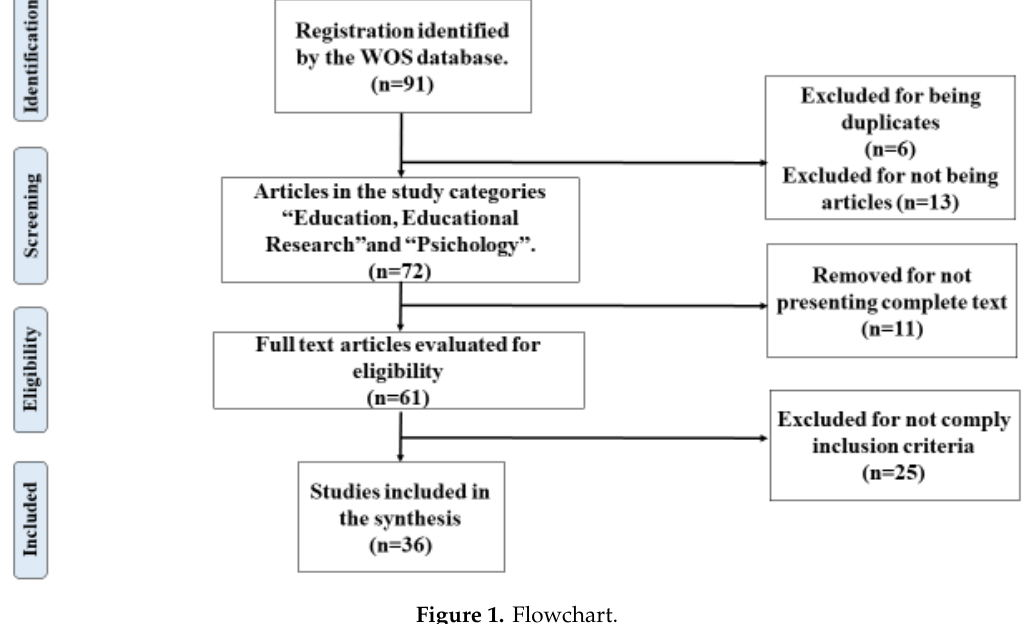
Figure 1. Flowchart. Figure 1.